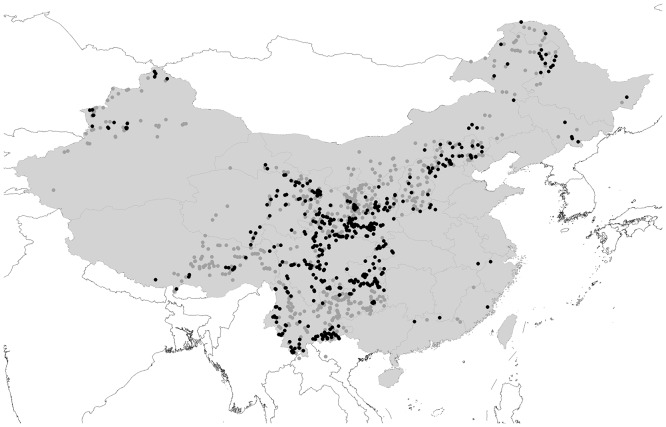
Map of sites sampled across China for bumblebees.Grey spots, all bumblebee records; black spots, records of species of the subgenus Megabombus. Map was created using a free computer program DIVA-GIS(http://www.diva-gis.org/download) and free spatial data (http://www.diva-gis.org/Data).